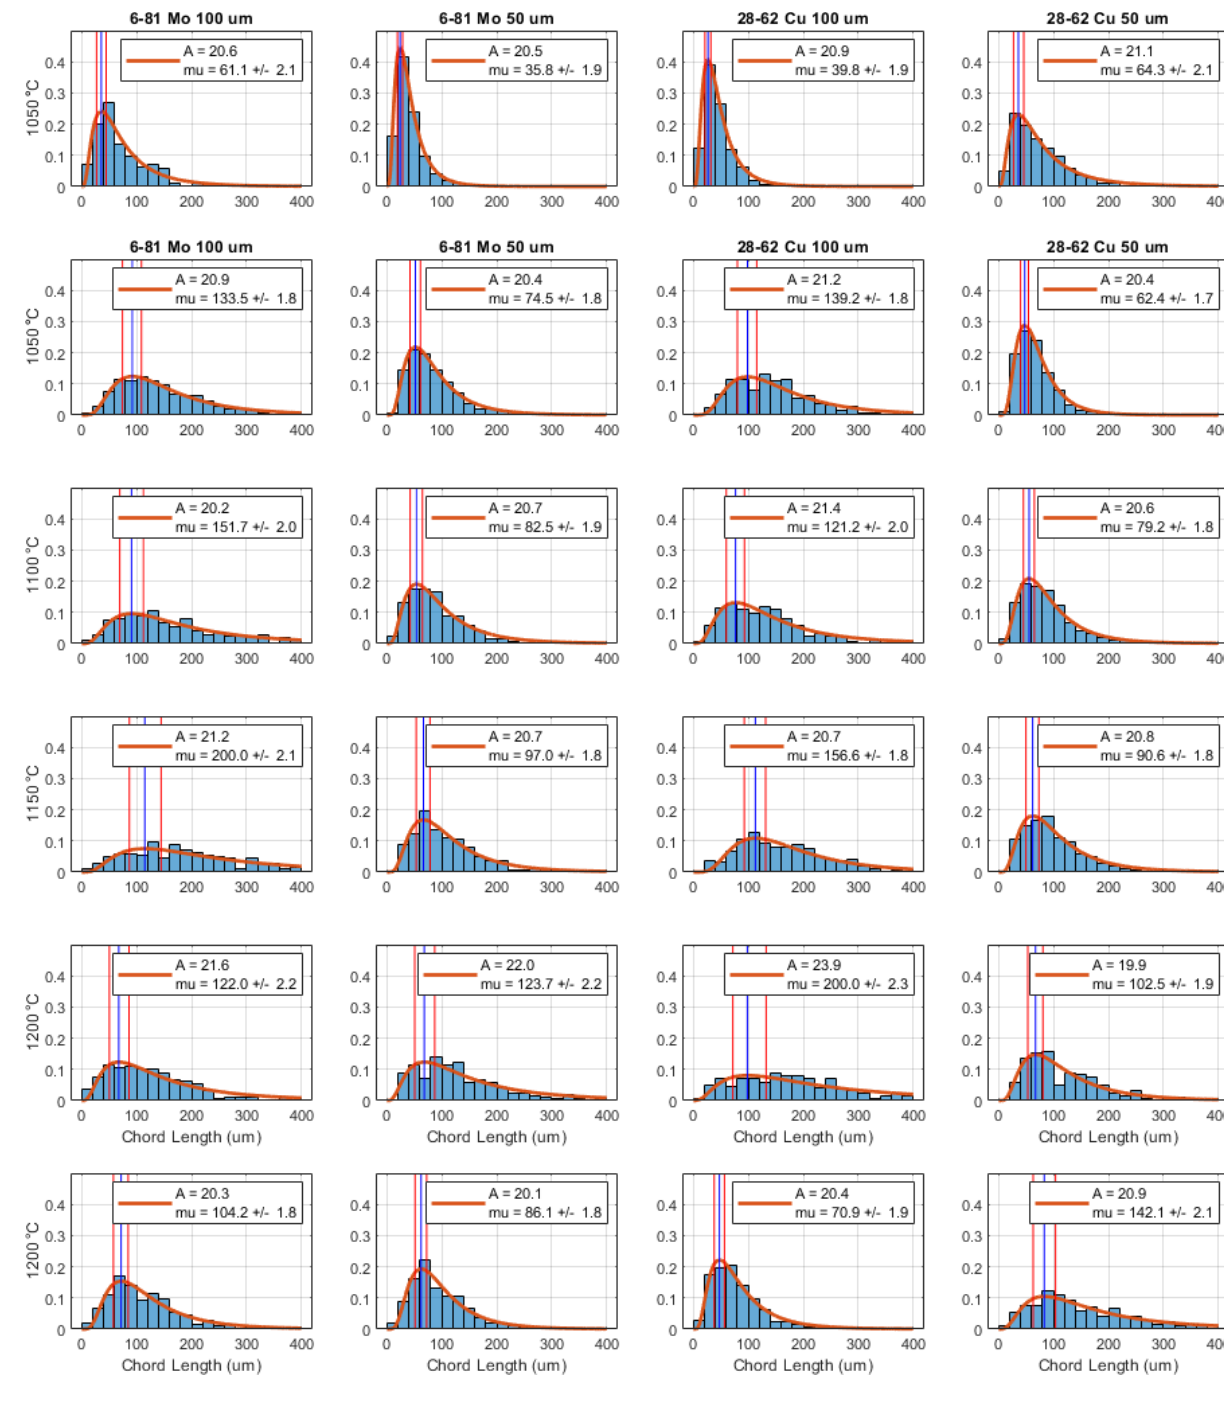
Figure A2. Chord-size distribution for each foil